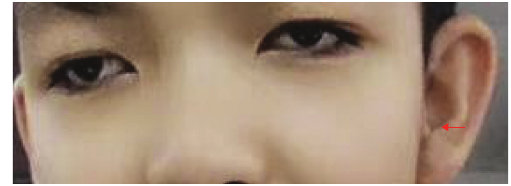
Figure 1: Eyes features of the patient at the age of 15. Note the downslanting palpebral fissures and strabismus.